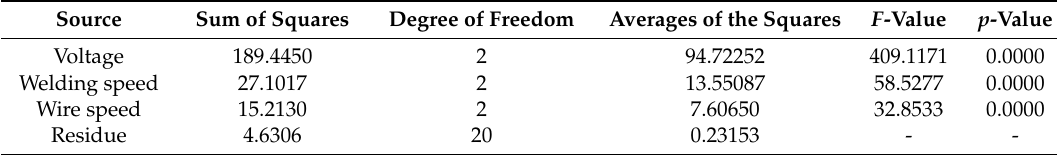
Table 4. ANOVA for the heat-affected zone.